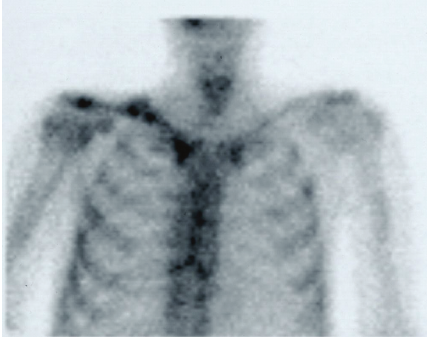
Figure 2: Preoperative bone scan demonstrating hot uptake at both ends of the fractured